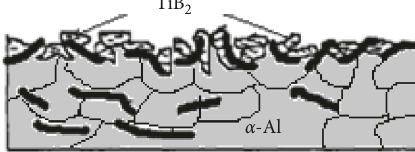
Figure 7: Schematic diagram of TiB